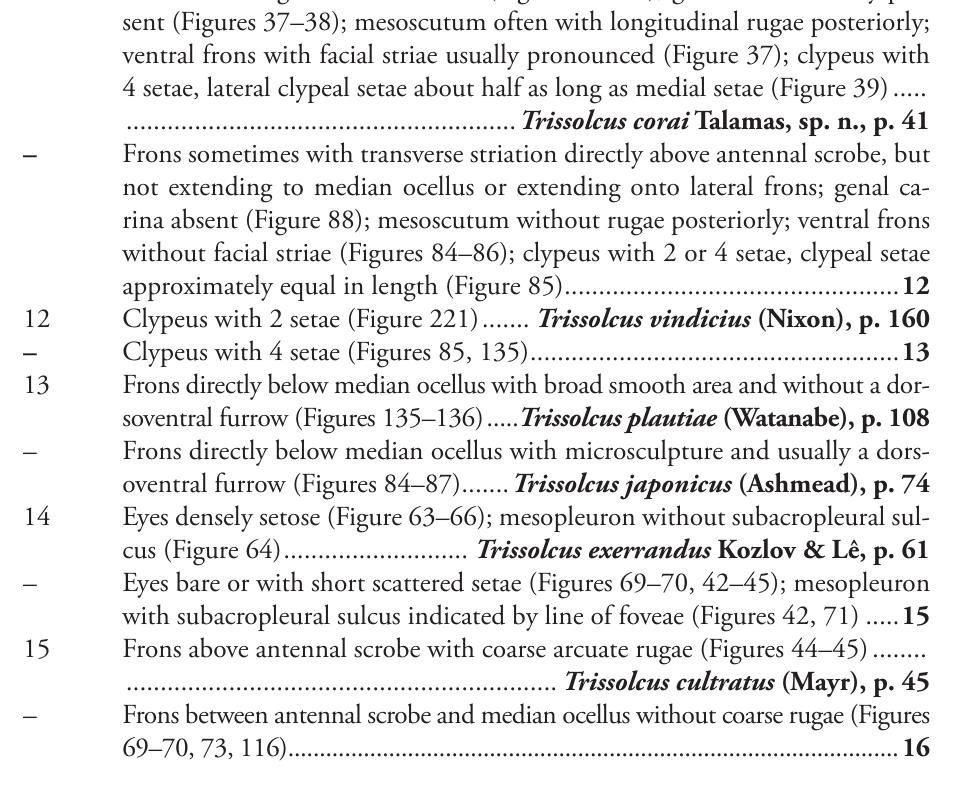
throughout anterior half of tergite (Figures 36, 89, 134) ........................... 10 Frons above antennal scrobe with irregular raised lines (Figures 92–93); mes- oscutum with microsculpture effaced posteriorly (Figure 91); median lobe of mesoscutum with oblique rugulae (Figure 91); mesoscutellum entirely